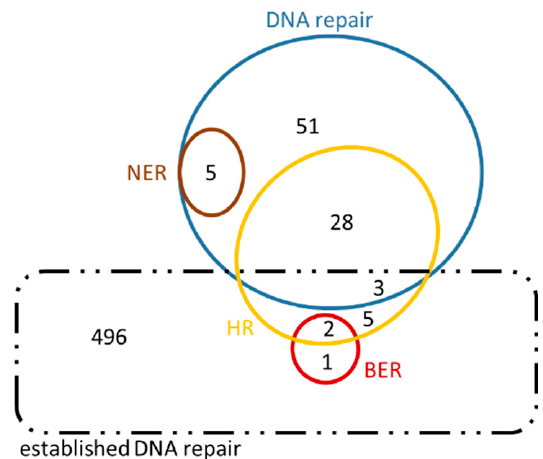
Figure 8. Venn diagram of Homo sapiens genes in their putative ‘new roles’. This diagram also contains an intersection of the genes in ‘new roles’ with ‘established DNA repair’ genes, in order to highlight the great number of genes arisen from this analysis that have not been previously characterized under the inclusive term ‘DNA repair’ (dashed black line).